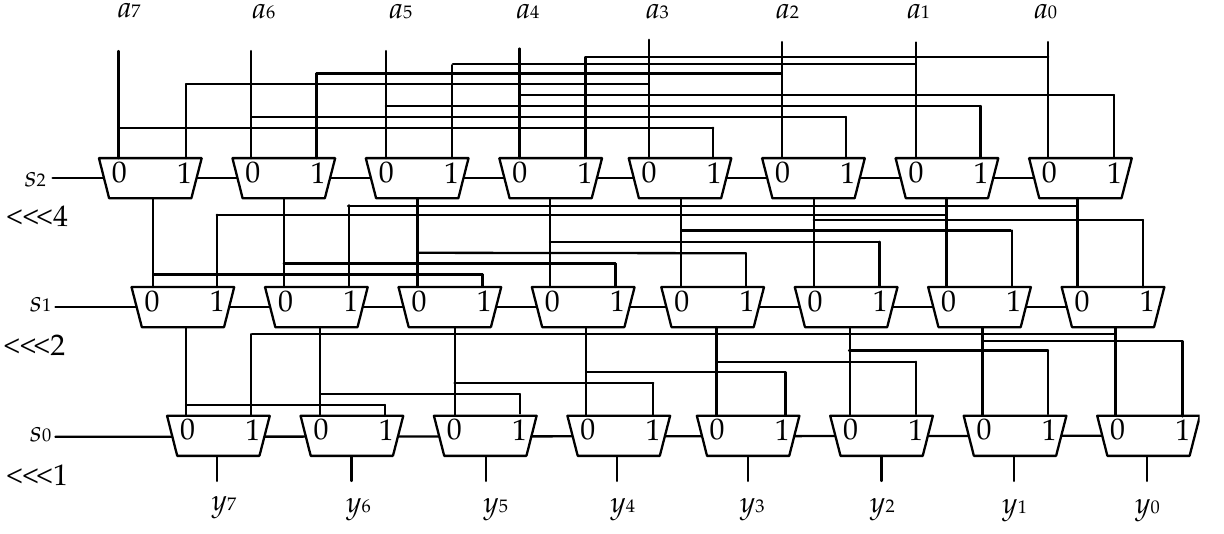
Figure 3. The circuit structure of the 8-bit barrel shifter.